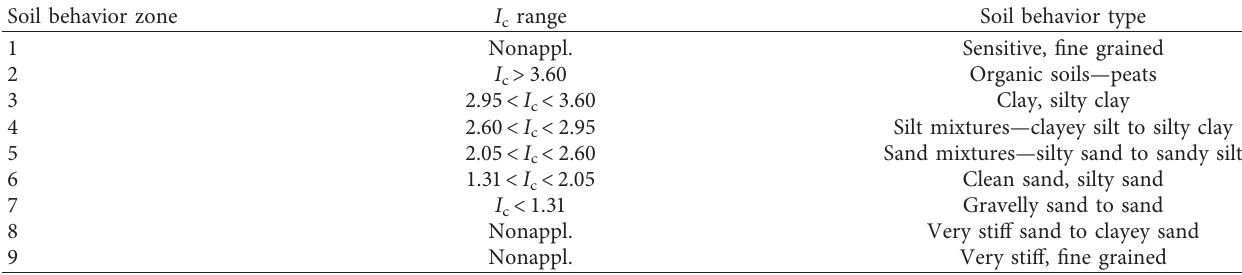
Table 1: Soil behavior type index I